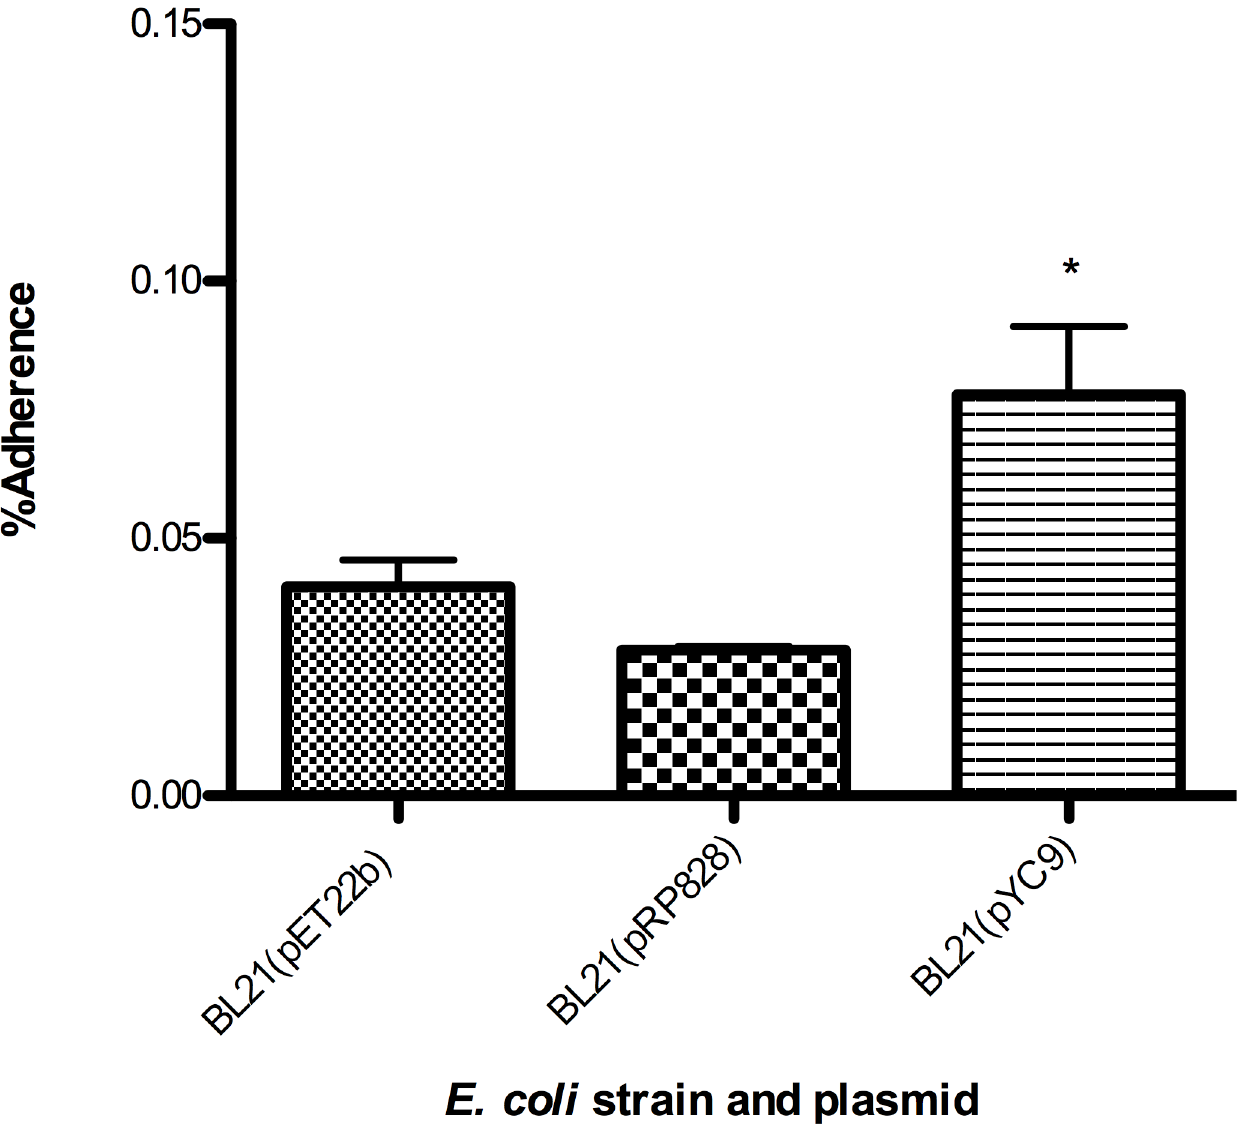
Fig 7. Adherence potential of R . prowazekii Adr2 expressing E . coli . Expression of R . prowazekii Adr2 in E . coli (BL21) is not sufficient to mediate cell adherenceto EA.hy926 cells. The results are expressedas percentagesof recoveredadherent bacteria basedon the total bacterial input. Results are shown as the mean ± SD (P values: * =